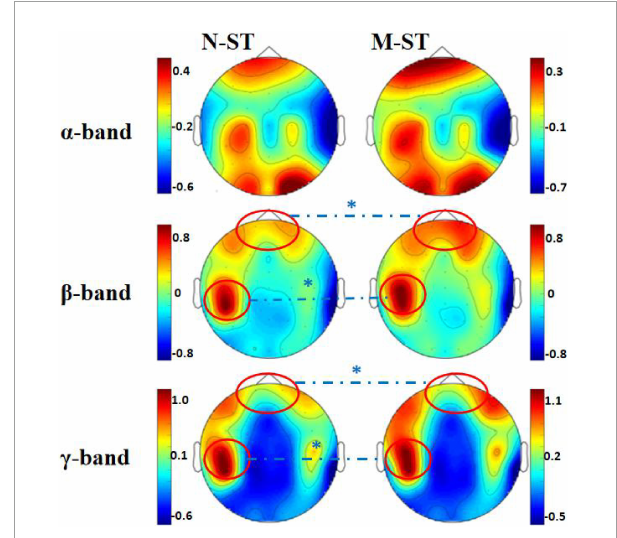
FIGURE2 Mean EEG power spectrum of subjects. In the figure, the "N-ST" group is on the left and the "M-ST" group on the right. The EEG power distribution characteristics of α , β , and γ bands are shown, respectively. The red circle and " ∗ " indicate the areas with significant differences in power spectrum statistics. It can be seen from the figure that the power produced by the prefrontal cortex and left motor cortex of the "M-ST" group was significantly higher than that of the "N-ST"